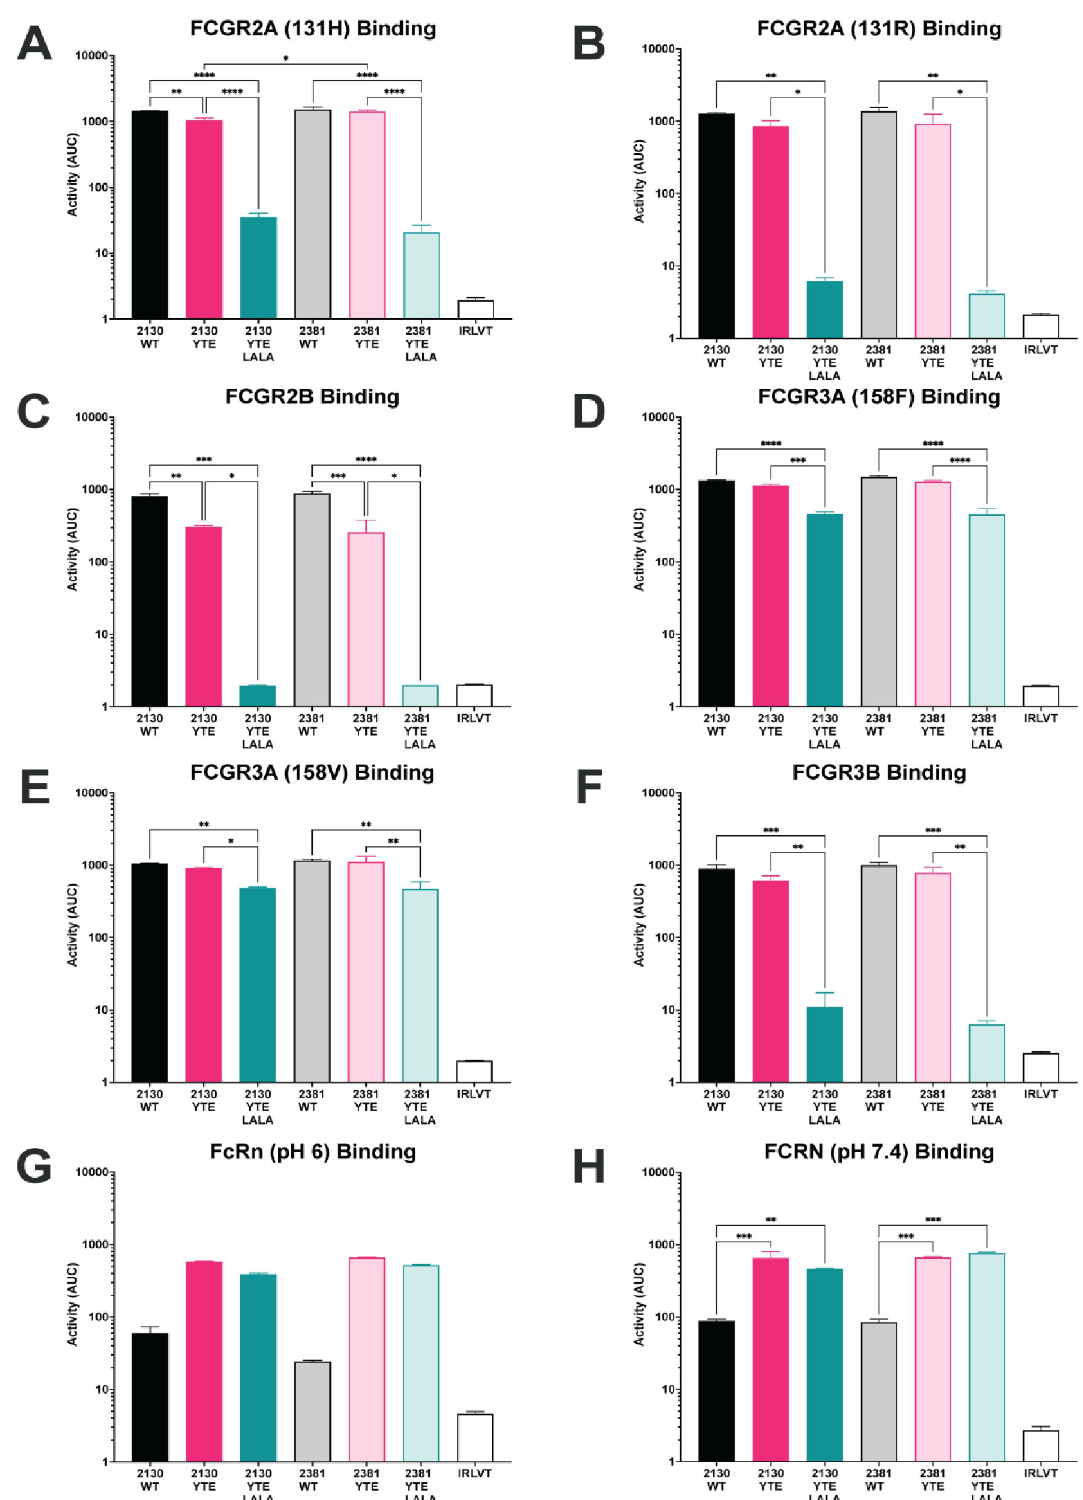
Fig 2. Binding of the monoclonal antibody variants to Fc receptors. The bar graphs present the overall binding of the monoclonal antibody variants to the indicated Fc receptor represented as the area under the curve calculated from the dilution curves presented in S1 Fig. Data are presented as the mean AUC ± standard deviation from two independent experiments. (A) FCGR2A 131H; (B)